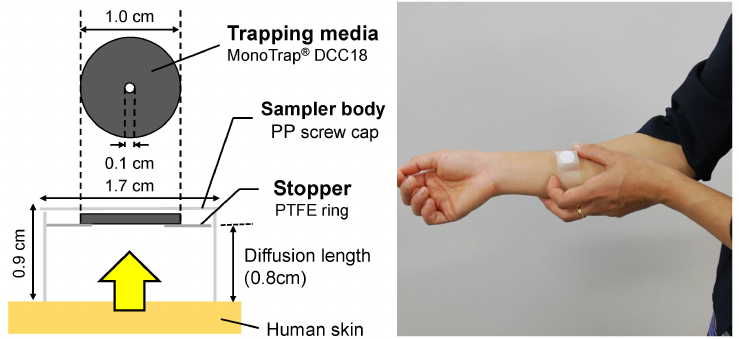
Figure 2. Schematic drawing of the PFS for the collection of γ -lactones and SCFAs. PFS was put on the surface of the non-dominant forearm of a healthy